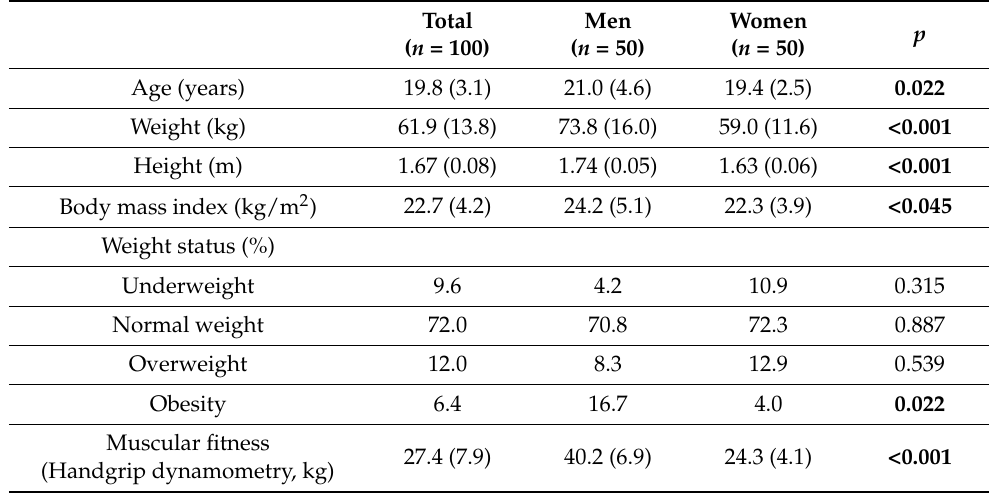
Table 1. Demographic, anthropometric and physical fitness variables of study population, by sex. Total